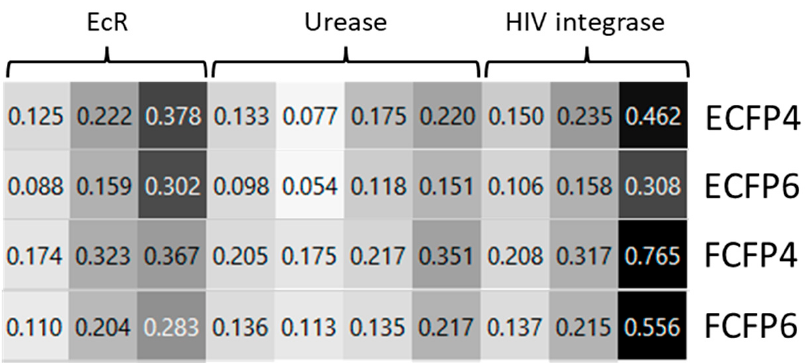
Figure 2. Calculated value (0 low similarity, 1 max similarity) of similarity index between DBH and the most potent compounds acting as ligands of EcR, urease, and HIV-1 integrase with ECFP4/6 and FCFP4/6 fingerprint similarity matrices.